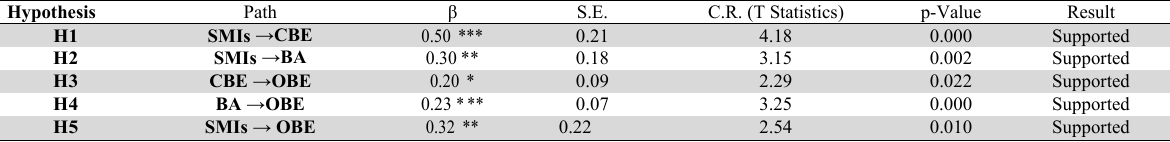
Hypothesis testing